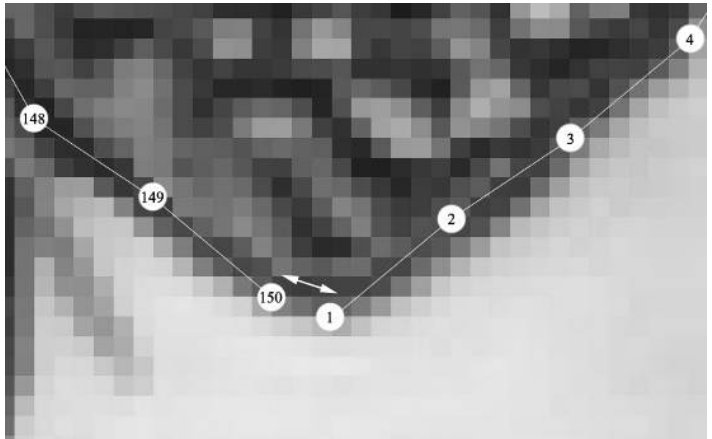
F IGURE 4.- Cropped photograph of the pronotum showing the anterior left portion of pronotum and the gap between the start and end